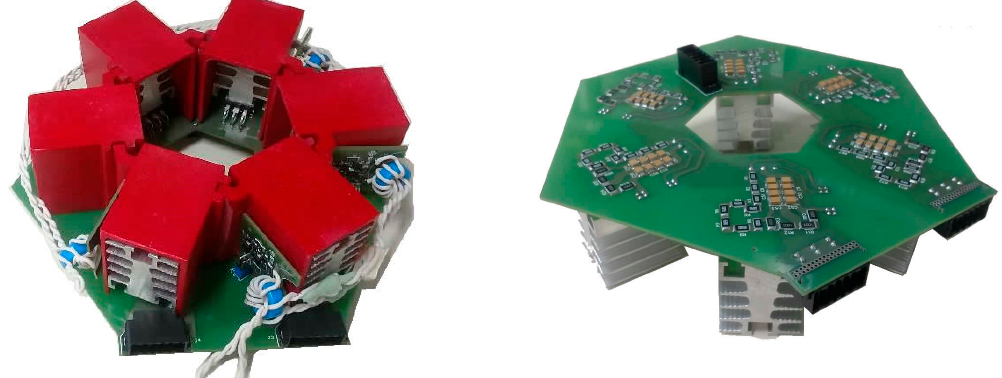
Figure 11. Photos of the top and bottom view of the hexagonal sub-module.